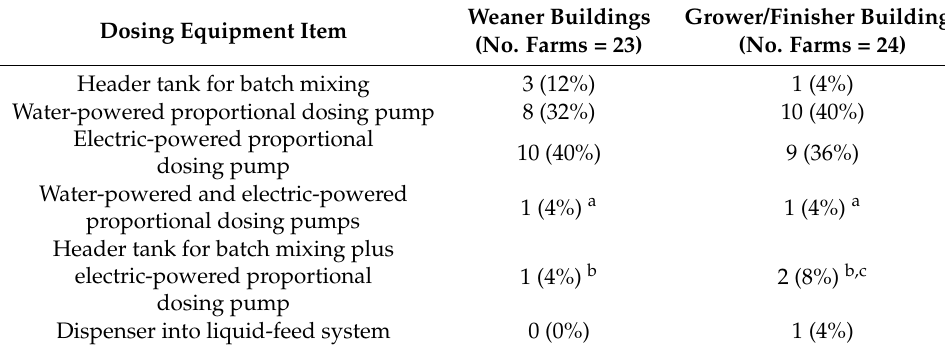
Table 1. In-water antibiotic dosing equipment used by farm managers on 25 single-site and multi-site pig farming